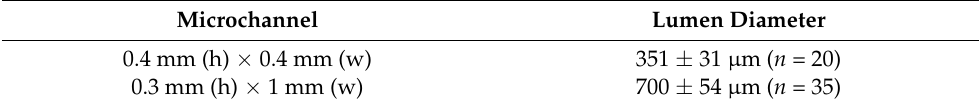
Table 2. Dimensions of the VoC lumens using VFP, depending on the channel dimensions.